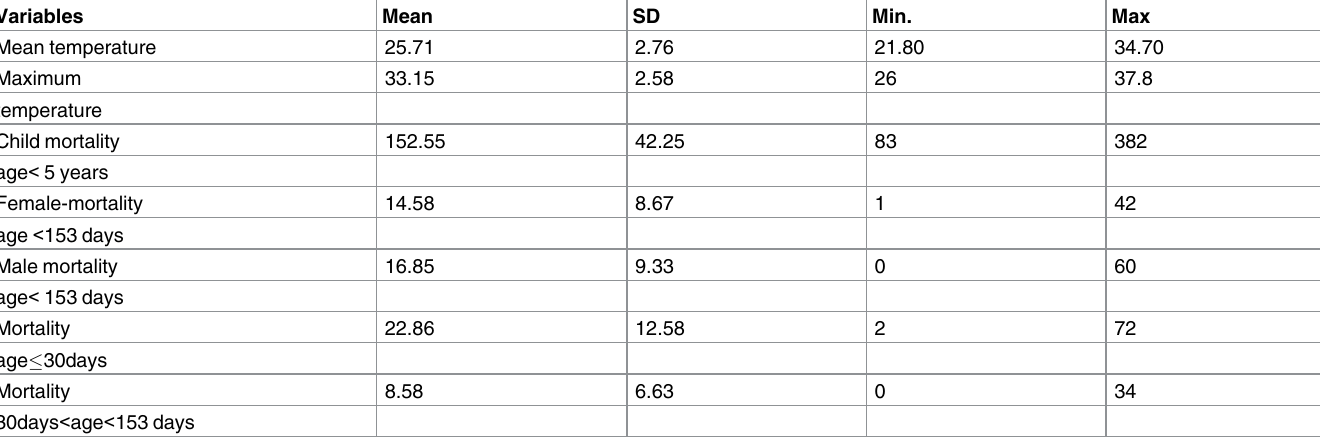
Table 1. Summarystatistics of variables used in the